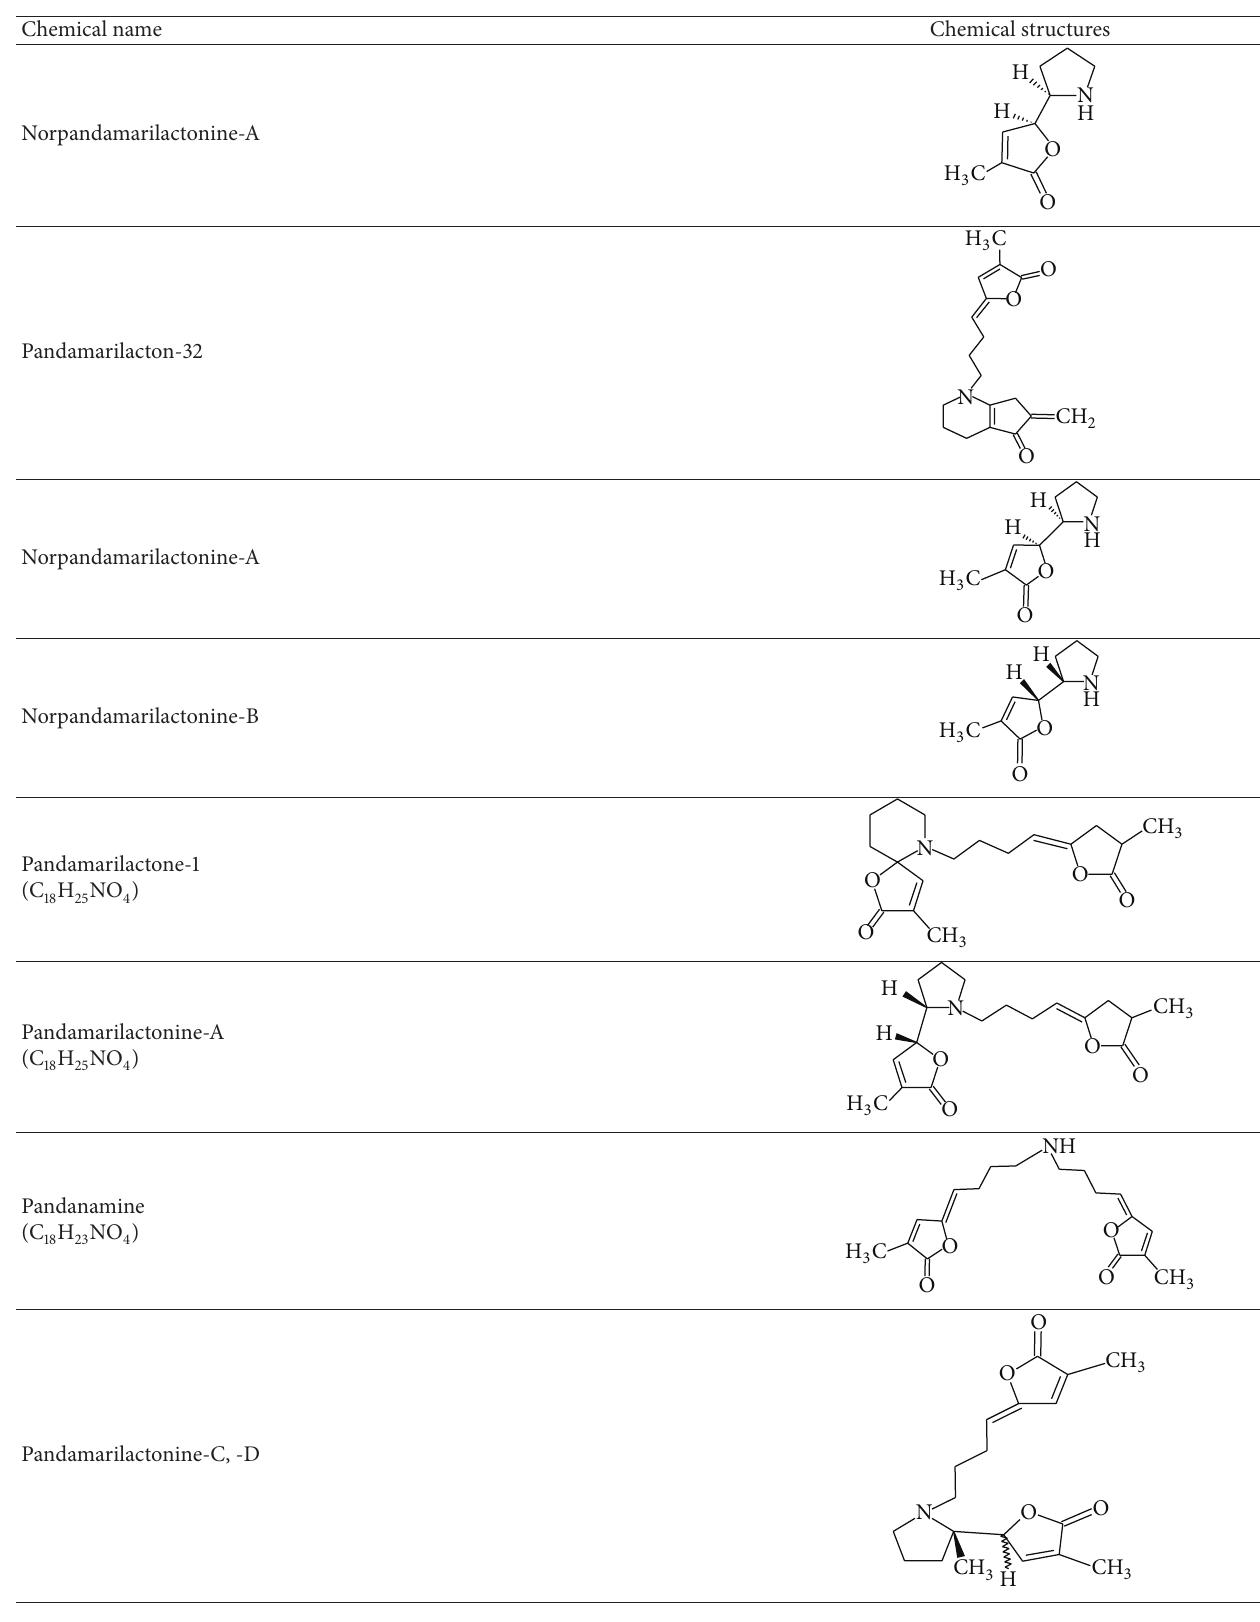
Table 4: Phytochemical structures in Pandanus